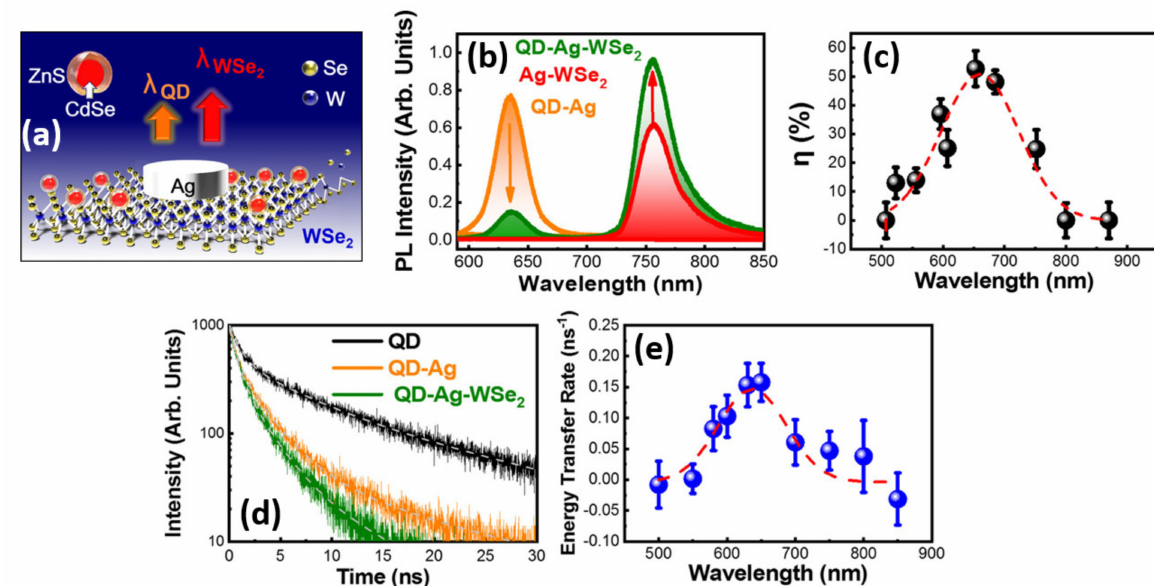
Figure 11. ( a ) Hybrid zero-dimensional core–shell CdSe/ZnS quantum dot (QD)/two-dimensional monolayer WSe 2 semicon- ductors with an Ag nanodisk (ND). ( b ) PL spectra of the three samples. ( c ) Energy conversion efficiency from the CdSe QD to WSe 2 . ( d ) PL decay curves of the QD peak (630 nm) in the QD, QD − Ag, and QD − Ag − WSe 2 structures with an Ag ND. ( e ) Energy transfer rate of QD in the QD − Ag − WSe 2 structure [58]. Figure reproduced with permission from ACS